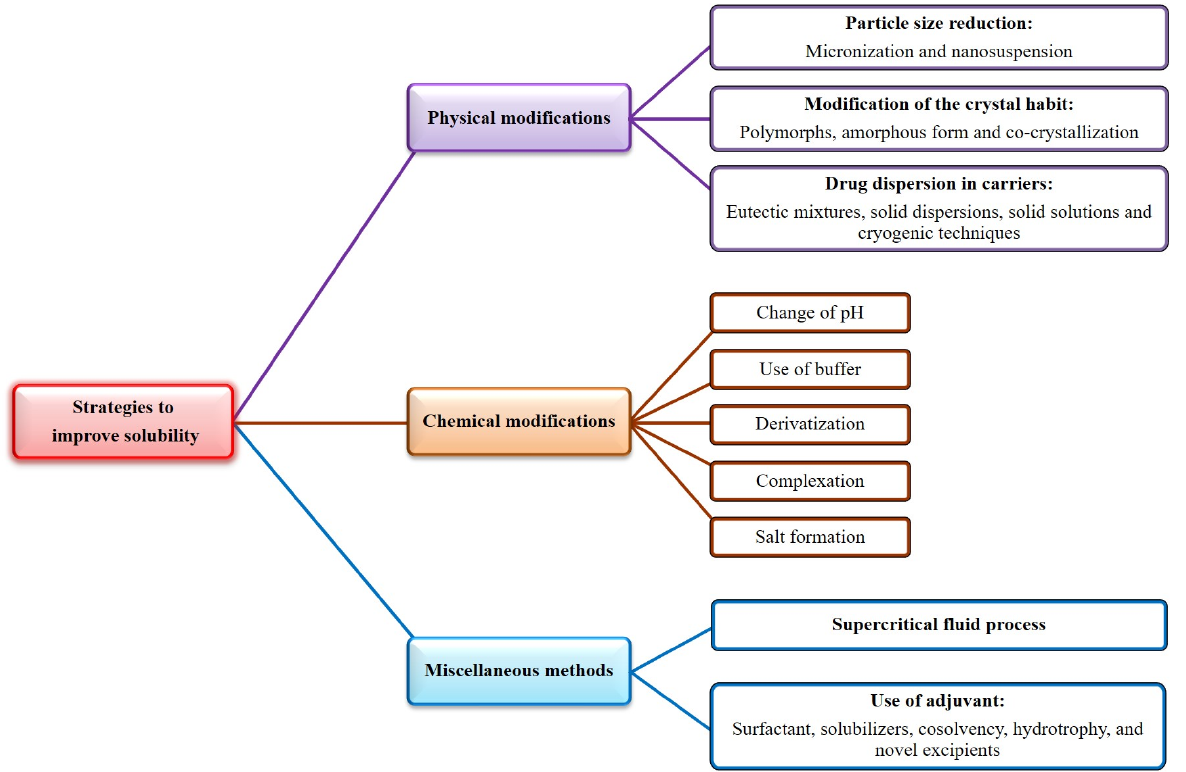
Figure 3. Various strategies to improve solubility.